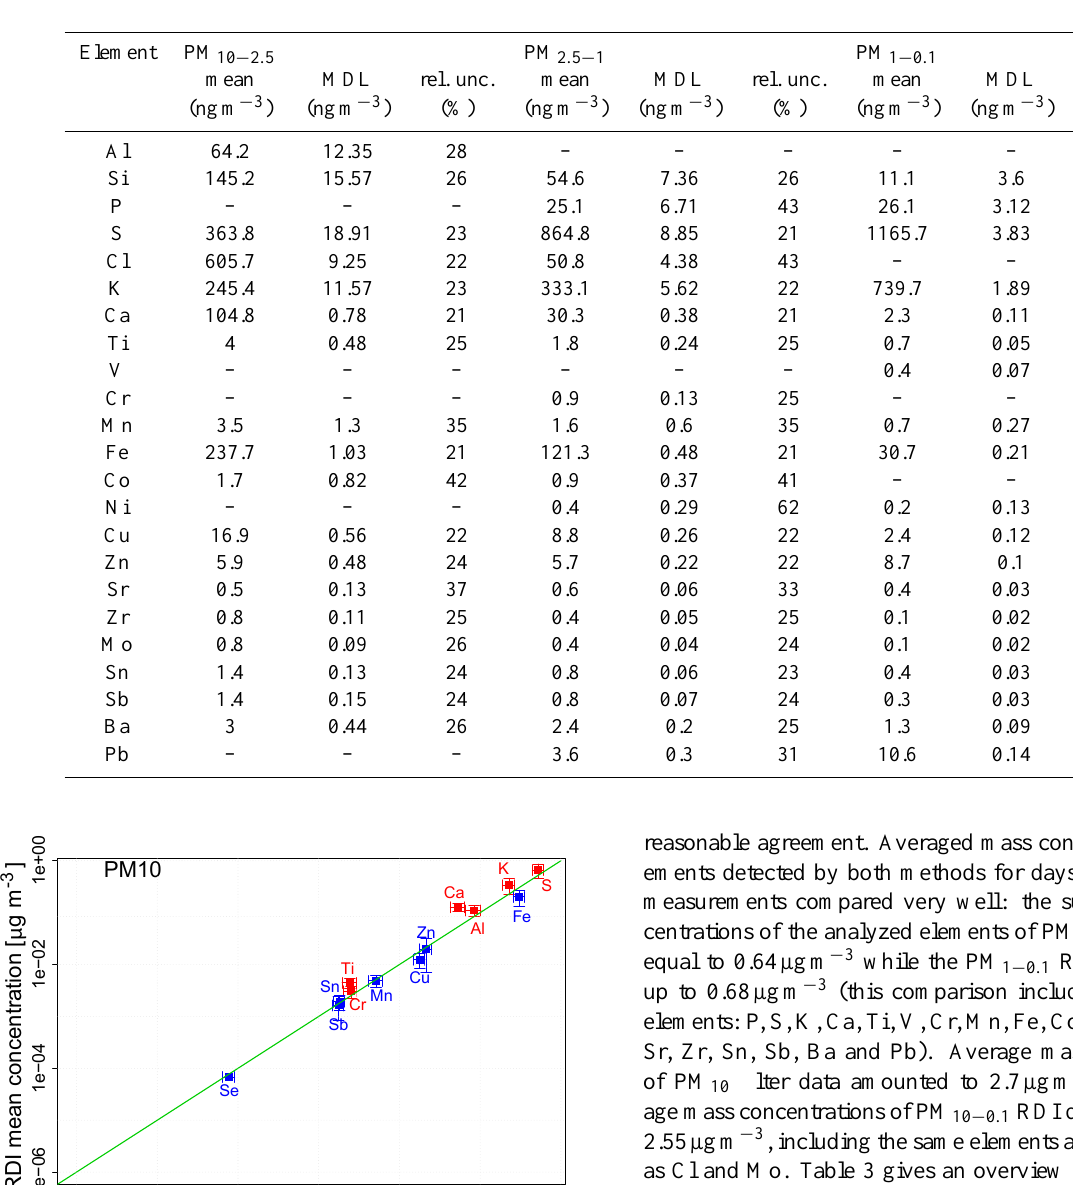
Table 3. Mean values, minimal detection limits and relative uncertainties (in %) for all three size ranges, PM 10 − 2 . 5 , PM 2 . 5 − 1 and PM 1 − 0 . 1 in ngm − 3 .